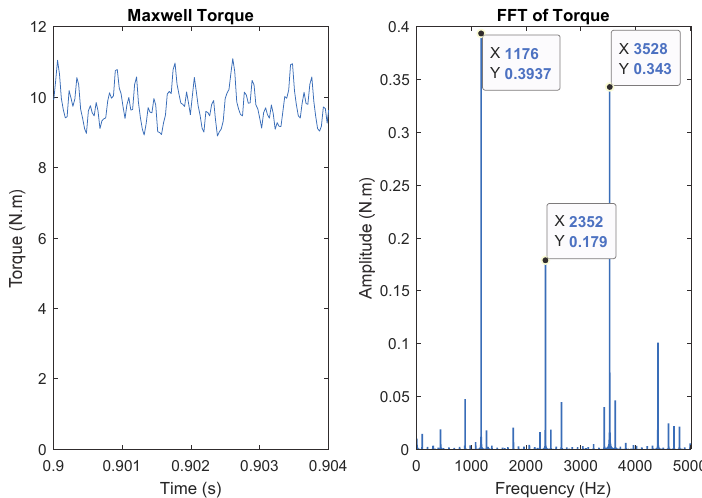
Figure 3. FFT of Finite-Element torque for the three-phase IM with 48 bars.